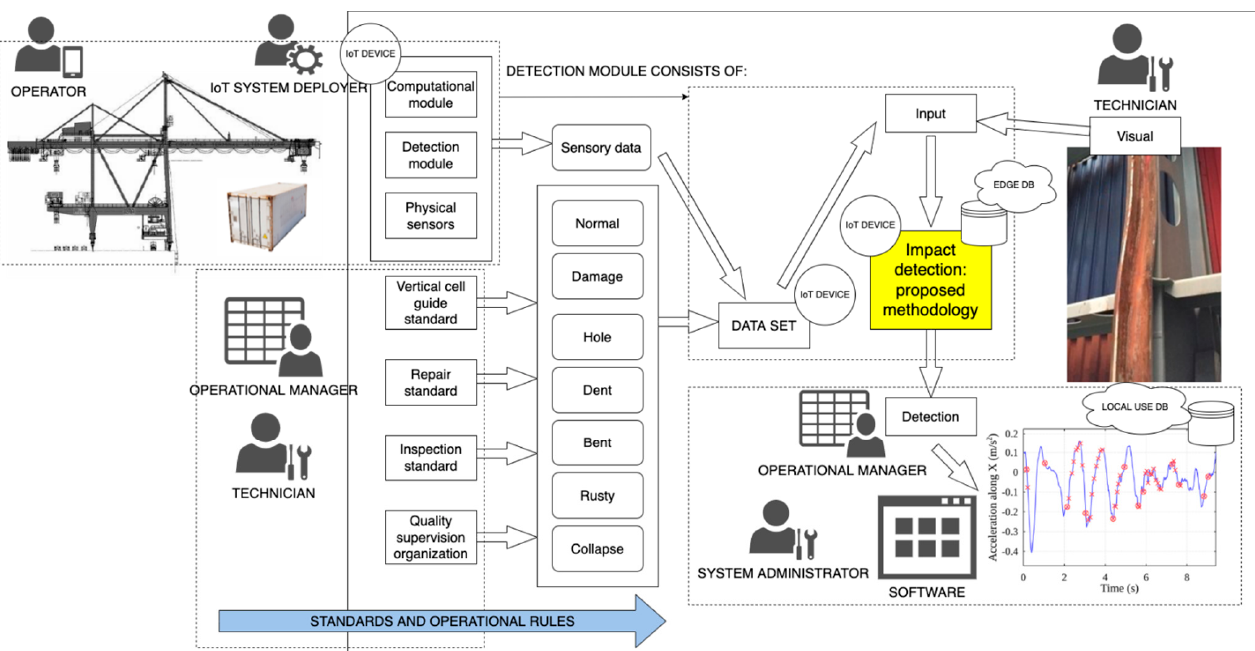
Figure 4. The high-level schematic of the process of data collection using the IoT sensor for vertical cell guide damage detection, using the frequency threshold detection algorithm and the visual inspection policy.